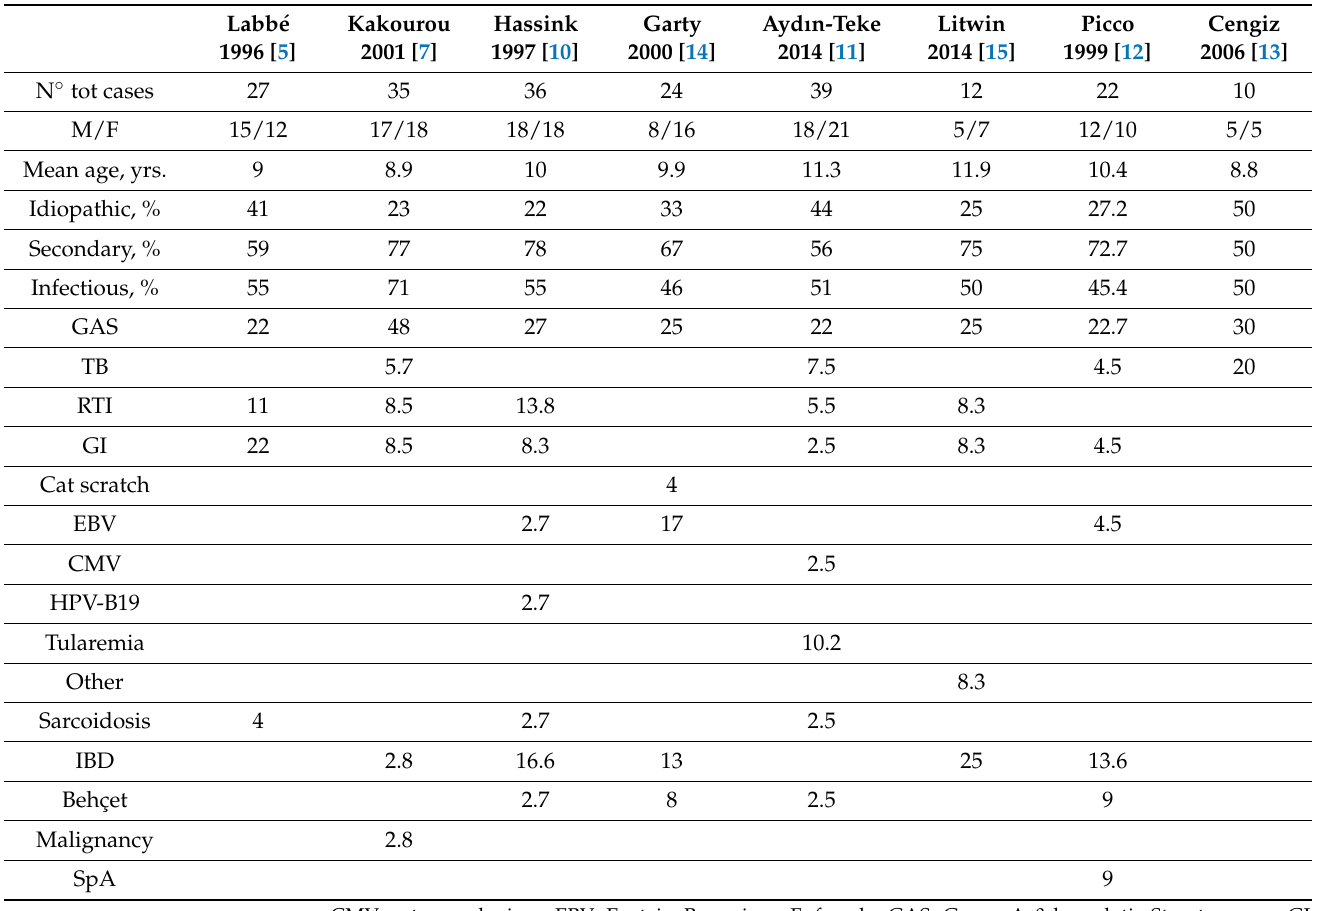
Table 2. Etiologic and epidemiologic data extracted from the pediatric cases